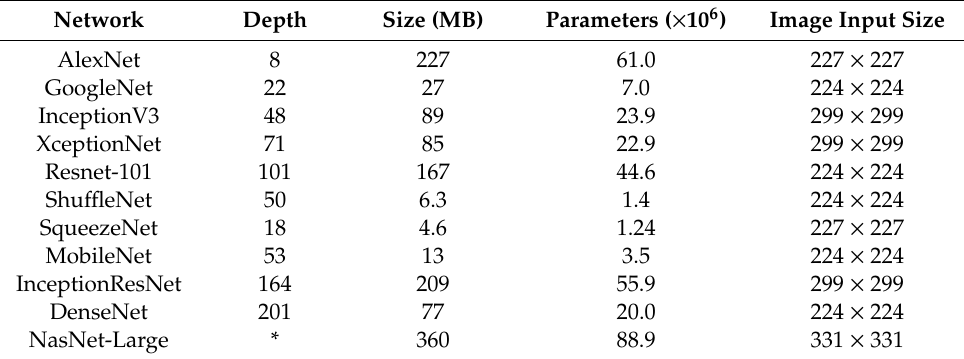
Figure 5. Data flow in method P1. Table 2. Pretrained convolutional neural networks (CNNs) and their properties.